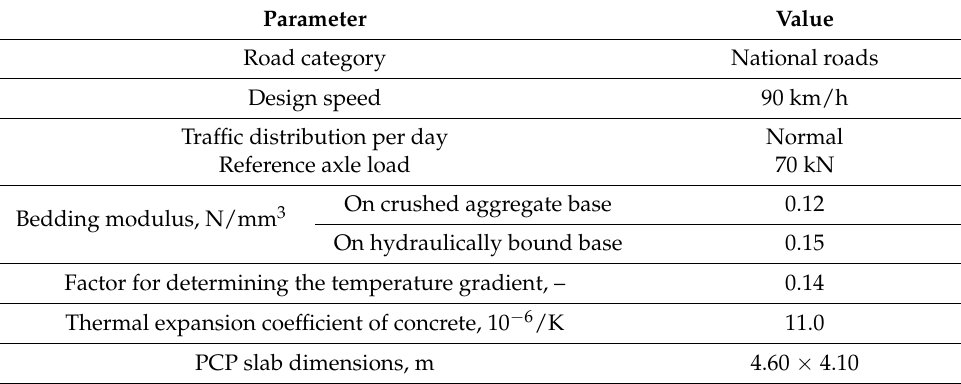
Table 3. Input parameters for calculation according to RDO Beton